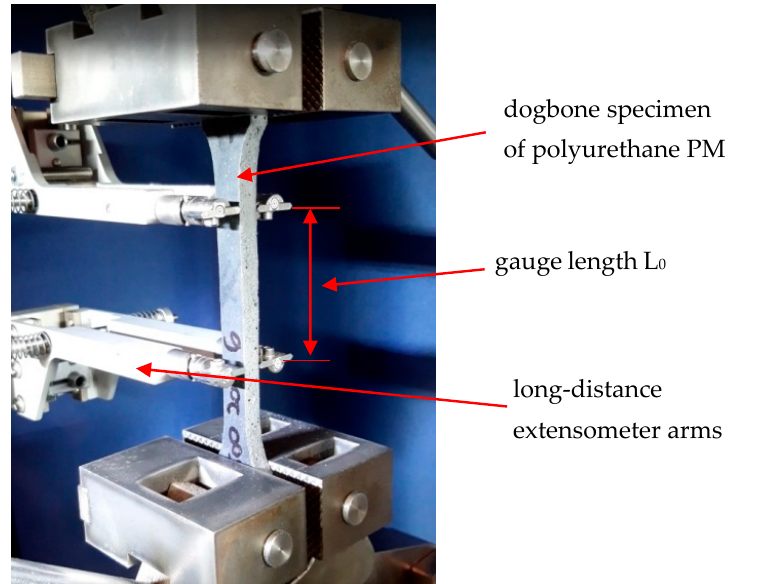
Figure 3. Uniaxial tension test of a dogbone specimen.